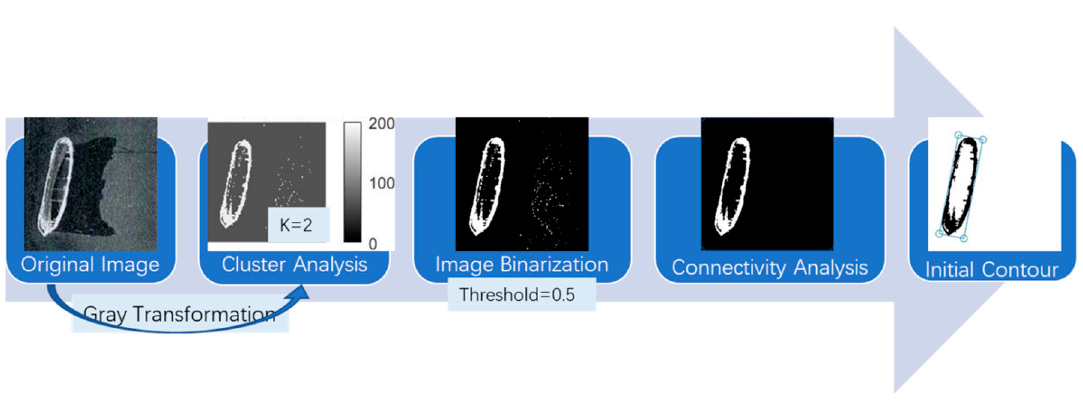
Figure 4. Core process of initial contour generation.